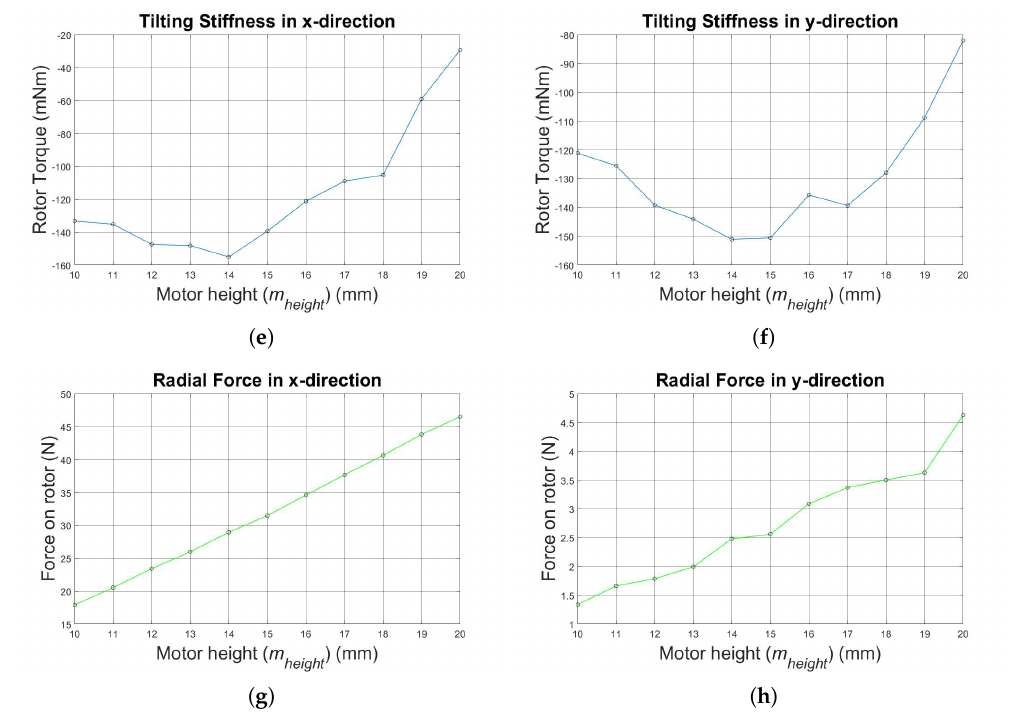
Figure 8. Simulation results for increasing motor height: ( a ) axial stiffness, ( b ) rotor torque, ( c ) radial stiffness in the x-direction, ( d ) radial stiffness in the y-direction, ( e ) tilting stiffness in the x-direction, ( f ) tilting stiffness in the y-direction, ( g ) radial bearing force in the x-direction and ( h ) radial bearing force in the y-direction.